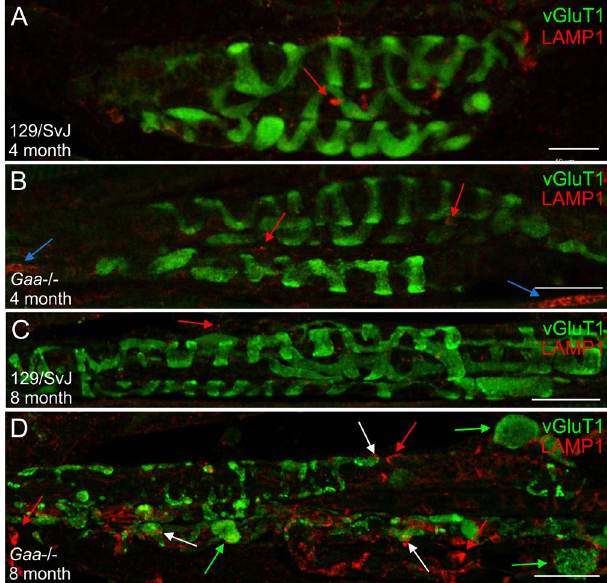
Figure 5. Accumulation and aggregation of lysosomes in muscle spindles from Gaa −/− mice. The structure and distribution of lysosomes was investigated using anti-LAMP1 antibodies in 4-month-old ( A,B ) and 8-month-old ( C,D ) 129/SvJ control mice ( A,C ) and Gaa −/− mice ( B,D ). The structure of the sensory nerve terminal (stained by antibodies against vGluT1; green channel) was indistinguishable in 4- and 8-month-old muscle spindles from wildtype mice and in 4-month-old Gaa −/− mice. In contrast, in 8-month-old Gaa −/− mice (category 2), the sensory nerve terminal had formed several varicosities within the spindle matrix (green arrows in panel ( D )), had retraced from the intrafusal fibers and had lost the typical annulospiral morphology. Lysosomes were barely detectable in sections from 129/SvJ mice at 4- and 8 months of age (red arrows in panels ( A,C )). In contrast, lysosomes were significantly enlarged and had formed aggregates in 4-month-old Gaa −/− mice (red and blue arrows in panel ( B ), respectively). By 8 months (panel ( D )), lysosomes were abundant, highly aggregated (red arrows) and often associated with the varicosities formed by the sensory nerve terminals of Gaa −/− mice (white arrows). Scale bars: 20